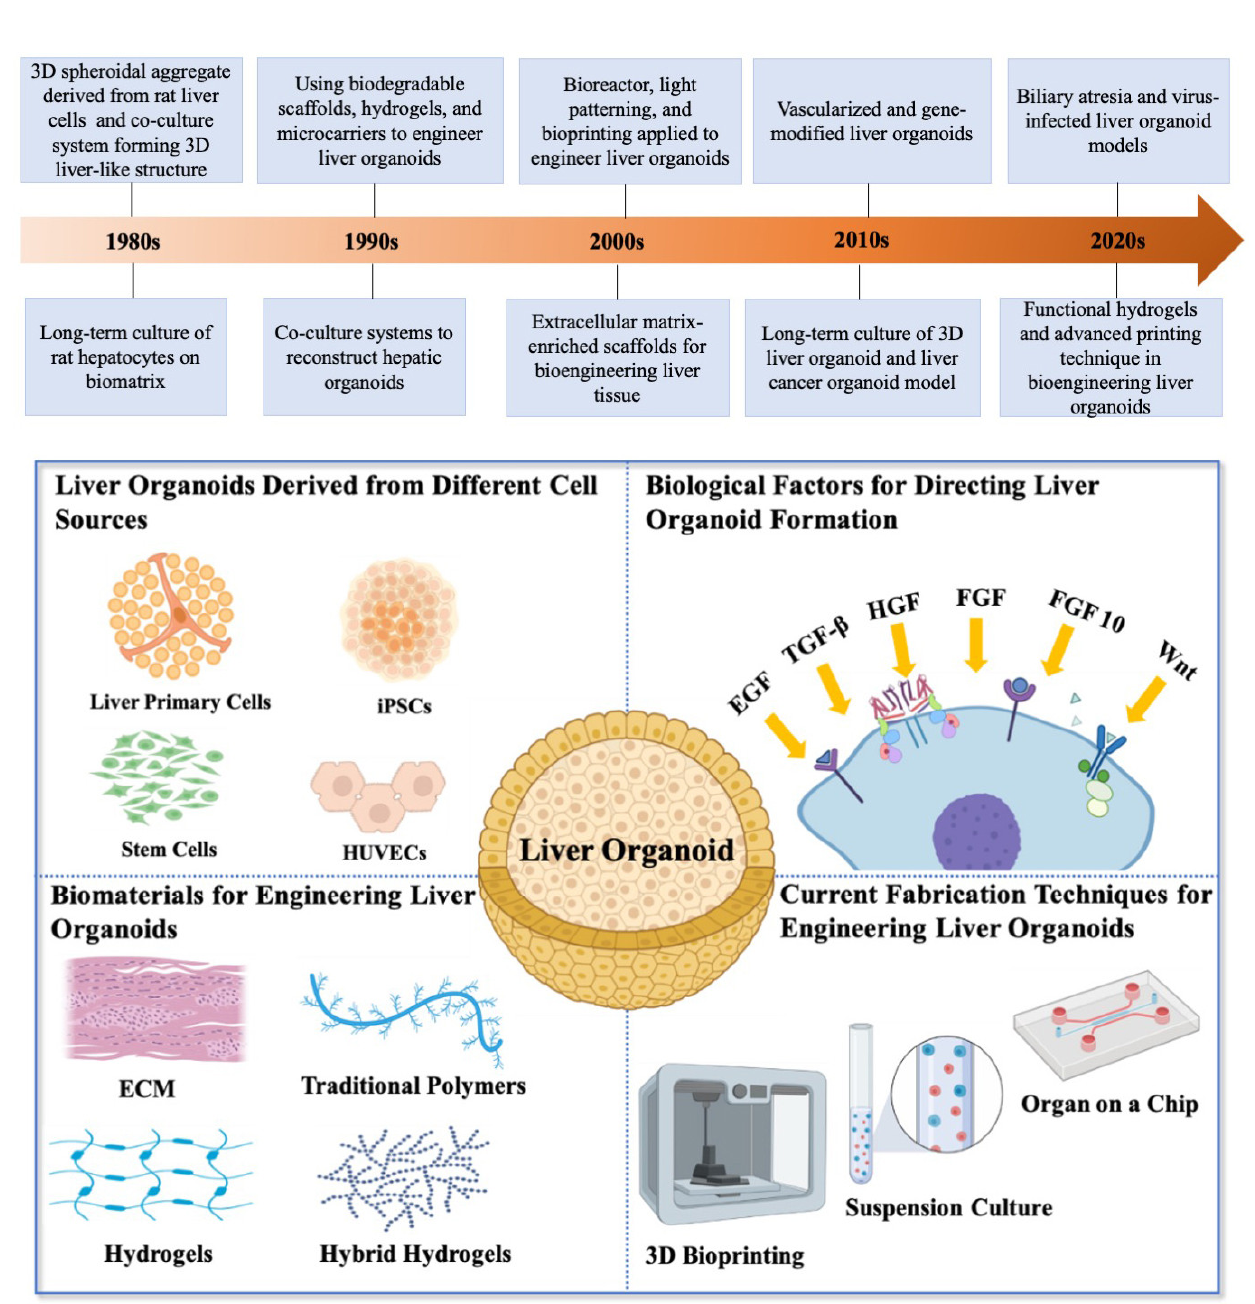
Figure 1. Timeline of the important events of bioengineering liver organoids (top): the 1980s wit- nessed the evolution of the 3D liver-like spheroidal aggregate [27–29]; the 1990s witnessed the development of liver organoids [30–35]; various techniques and biomaterials had been employed in bioengineering liver organoids in the 2000s [36–40]; the 2010s witnessed the development of functional liver organoids and their long-time culture and cancer models [23,24,41,42]; functional hydrogels and advanced printing technique have emerged in bioengineering liver organoids [45,46] and the liver organoids were exposed to biliary atresia and virus-infected models [43,44]; and the diagrammatic sketch of bioengineering liver organoids with different cell sources, biological factors, biomaterials, and fabrication techniques (bottom). iPSCs: Induced pluripotent stem cells; HUVECs: human umbilical vein endothelial cells; EGF: epidermal growth factor; TGF-b: transforming growth factor beta; HGF: hepatocyte growth factor; HGF: fibroblast growth factor.